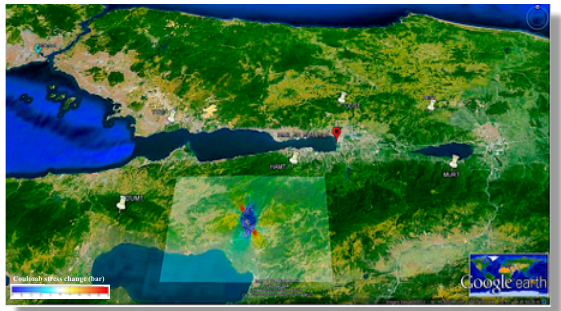
Figure 5: Map of Coulomb stress changes layer displayed on a Google Earth image for 13 September 1999. Model parameters: Mw =5.8, Strike = 272°, Dip = 40°, Rake = 175°, Depth =13 km, Time = 11:55 (UCT) and friction coefficient = 0.4. Epicentre of the 17 August Izmit earthquake and locations of BEST, DUMT HAMT, MURT, TUBI and UCGT stations have been marked on the map. Colour code indicates the Coulomb stress changes; dark blue and red are high stress values.